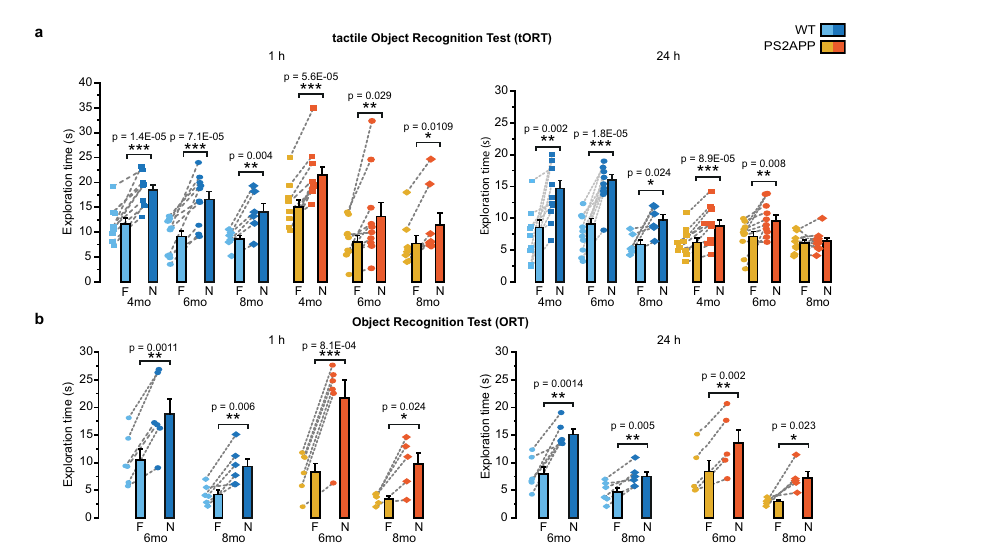
response amplitude, p =0.008. 6mo: n =17 astrocytes from 2 WT and n =13 astrocytes from 3 PS2APP mice. For amplitude, only astrocytes with at least one active Ca 2+ md have been considered. d fEPSP slope before and after TBS (black arrow)inSSCxslicesfrom3,6,and8moWTand PS2APPmice(mean±SEM).3mo: n =8slicesfrom5WTand n =6slicesfrom3PS2APPmice;6mo: n =13slicesfrom9 WT and n =15 slices from 11 PS2APP mice; 8mo: n =8 slices from 4 WT and n =9slicesfrom5PS2APPmice. e Barhistograms(mean±SEM)andscatterplotsof fEPSP slope. 6mo: p =0.025; 8mo: p =0.033. n as in d . * p <0.05, ** p <0.01, *** p <0.001. Fisher ’ s exact test (pie charts), two-tailed Mann – Whitney test ( b , c ) and two-tailed Student ’ s t test ( e ). Source data are provided as a Source data fi le.